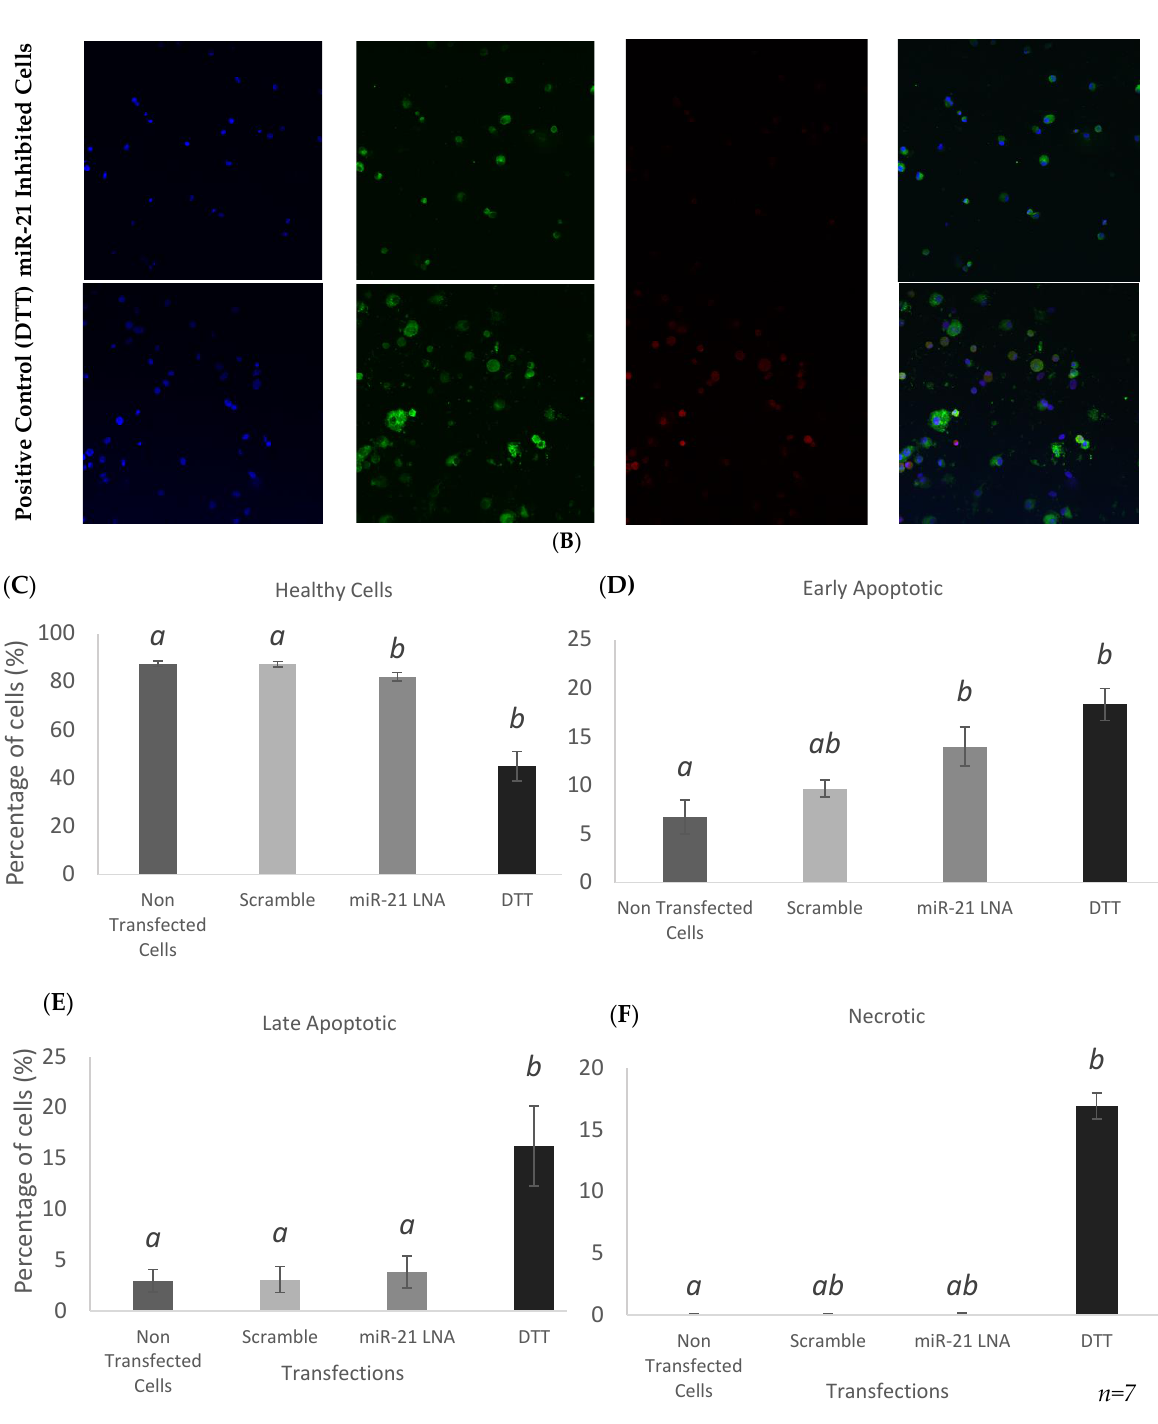
Figure 8. Annexin V/PI staining for apoptosis detection after miR-21 LNA treatment . Transfected cells were stained with Annexin V and PI to measure apoptosis using flow cytometry. Flow scatter plots ( A ), fluorescent images ( B ), and FlowJo quantification results ( C – F ) show that miR-21 inhibition decreases and increases the percentage of healthy cells ( C ) and early apoptotic cells ( D ), respectively, like the positive control, DTT. Different letters indicate significant differences, with b indicating a significantly different mean than a at p < 0.05. ab indicates no differences between a or b . Bars represent the mean ±